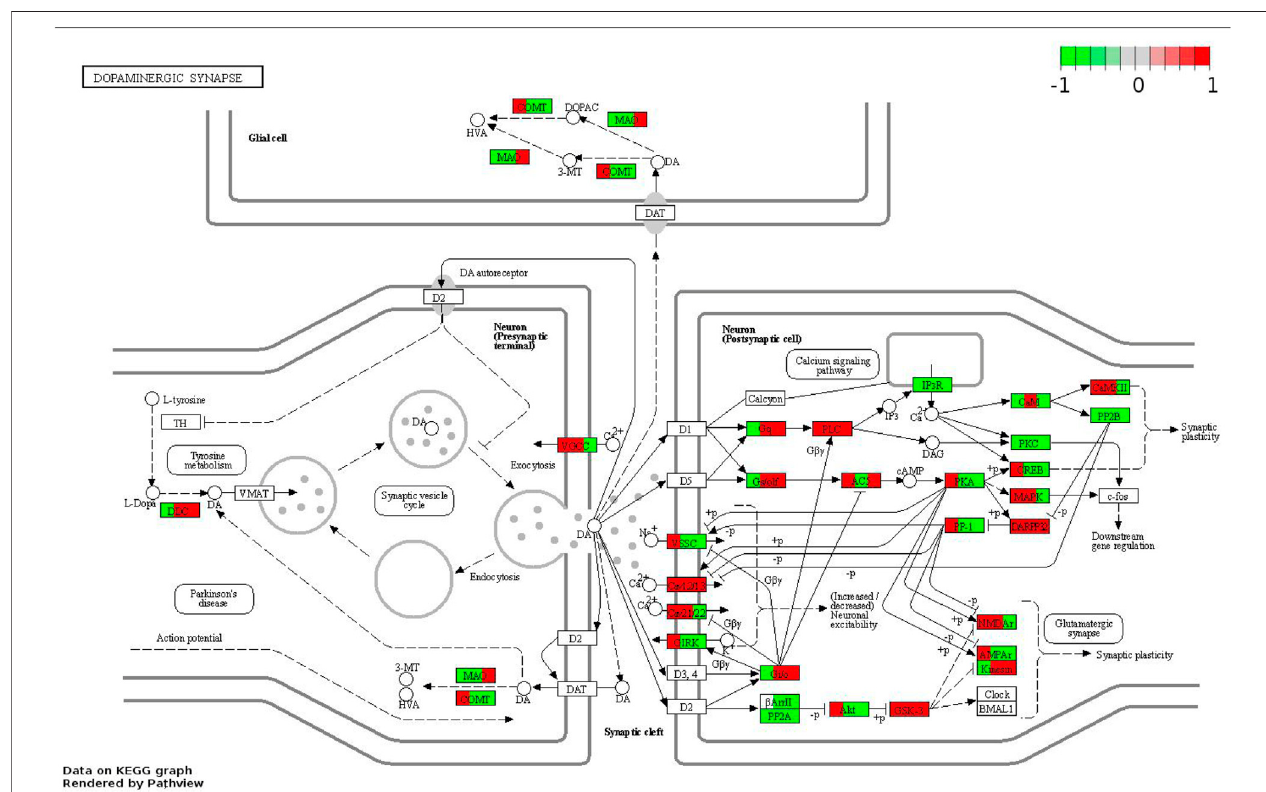
FIGURE 10 | Modulating the dopaminergic synapse signaling pathway of GPCRAC extracts against AD. Core differentially expressed protein mediated by GPCRAC extracts are colored in red (up-regulated) and green (down-regulated).